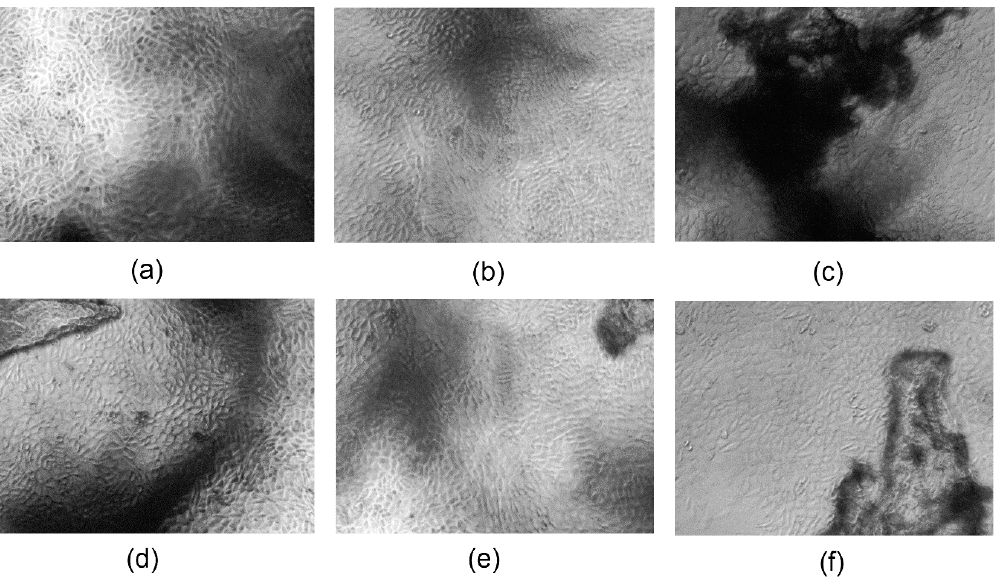
Figure 14. Qualitative cytotoxicity assessment of the developed samples on L929 mouse fibroblasts after six days of cell culture (40× magnification): ( a ) CS-ZnO-1; ( b ) CS-ZnO-2; ( c ) CS-ZnO-3; ( d ) CS-ZnO-4; ( e ) CS-ZnO-5; and ( f ) CS-ZnO-6.